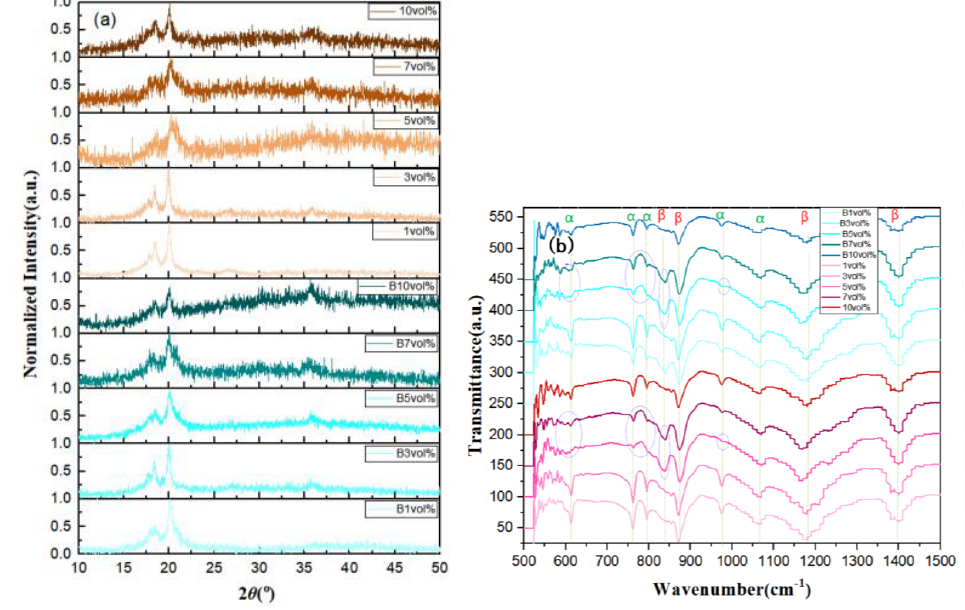
Figure 5. XRD ( a ) and FTIR ( b ) for 7FO/PVDF nanocomposite films with different doping